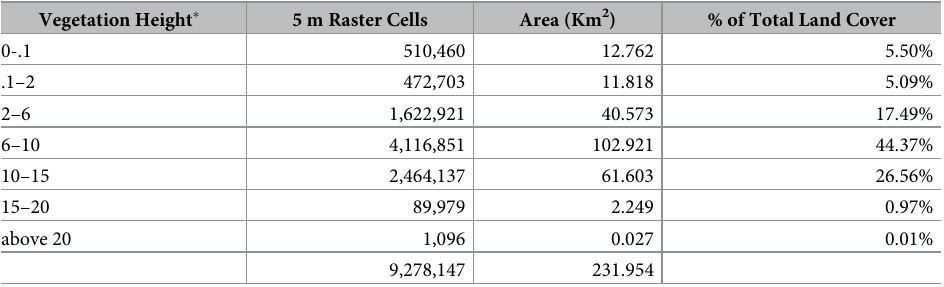
Table 3. Current land cover of the survey area. Vegetation Height